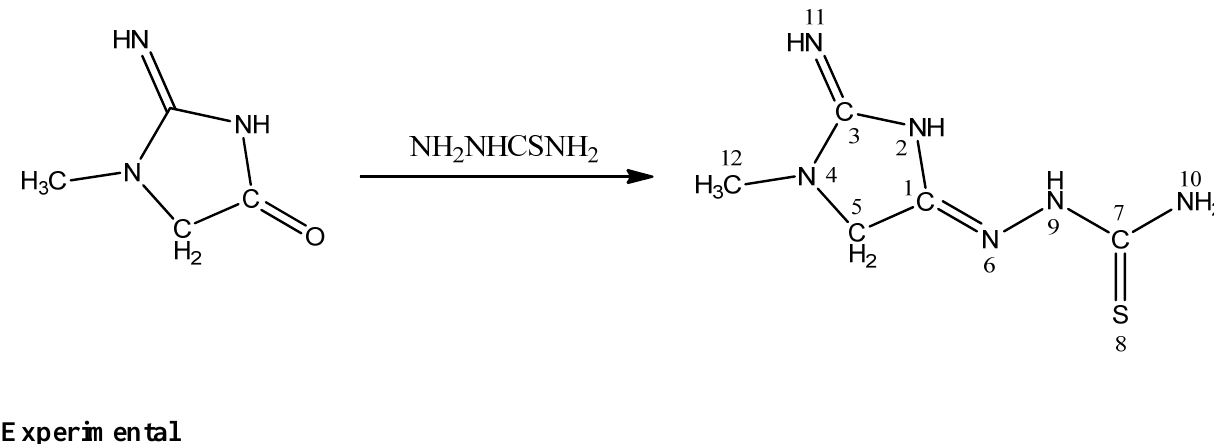
Experimental Synthesis of 2-(2-Imino-1-methylimidazolidin-4-ylidene)hydrazinecarbothioamide A mixture of 1-methyl-4-oxo-2-iminoimidazolidin (2.26 g, 0.02 mol) and thiosemicarbazide (1.82